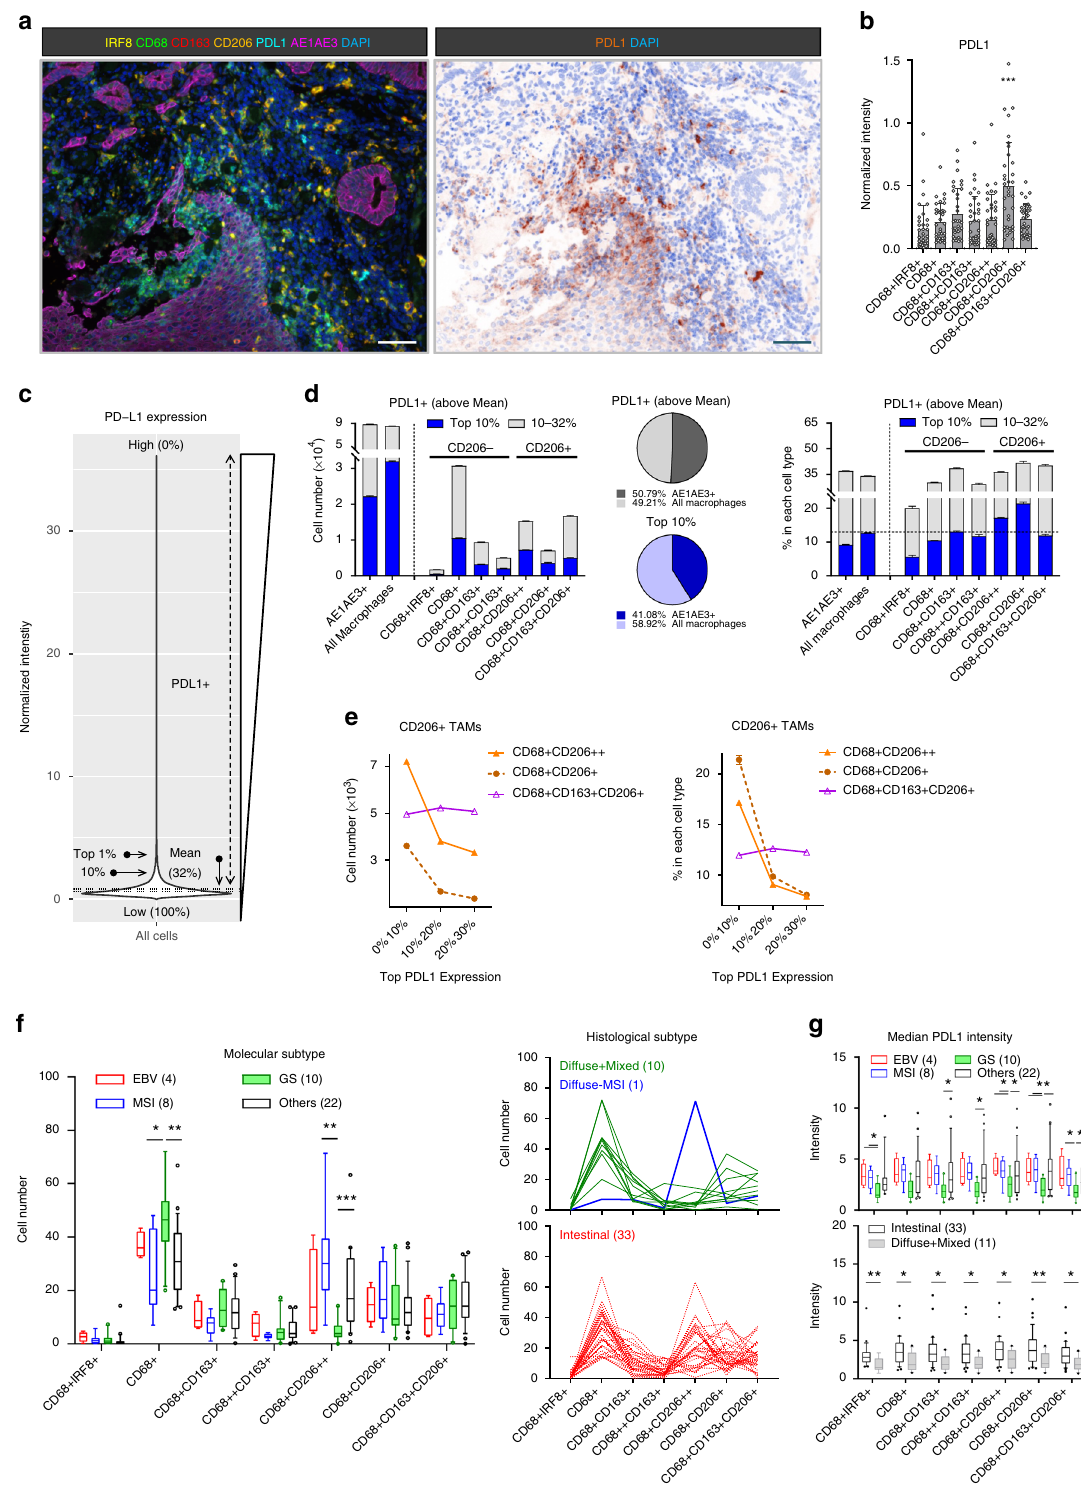
Fig. 5 PDL1 expression in GC is both TAM and GC subtype associated. a Representative images of PDL1 expression in the tumor core. Scale bar: 100 µ m. b Mean PDL1 intensity per patient ( n = 35) for each TAM population. Error bars represent mean ± SD. c Distribution of PDL1 expression on individual cells in a sampling cohort regardless of cell types. Equal number (10 4 ) of cells per patient ( n = 56, all ROIs included) were randomly selected to normalize between sample sizes. Cells were pooled as a sampling cohort. 32% of the cohort was de fi ned as PDL1 + with the mean expression of the cohort. d Cell number and percentage of different PDL1 intensity expressing cells in each cell type. Error bars represent mean ± SD of fi ve independent randomly selected subsampling cohorts. e PDL1 expression patterns of CD206 + TAMs: Cell number and percentage in each population. Error bars represent mean ± SD. n = 5. f Cell number and g median PDL1 expression on TAM populations in patients grouped by different GC subtypes. Box and whiskers represent mean ± 10 – 90 percentile. Each point/line represents one patient. * p < 0.05, ** p < 0.01, *** p < 0.001, and not signi fi cant (n.s.) Mann – Whitney U